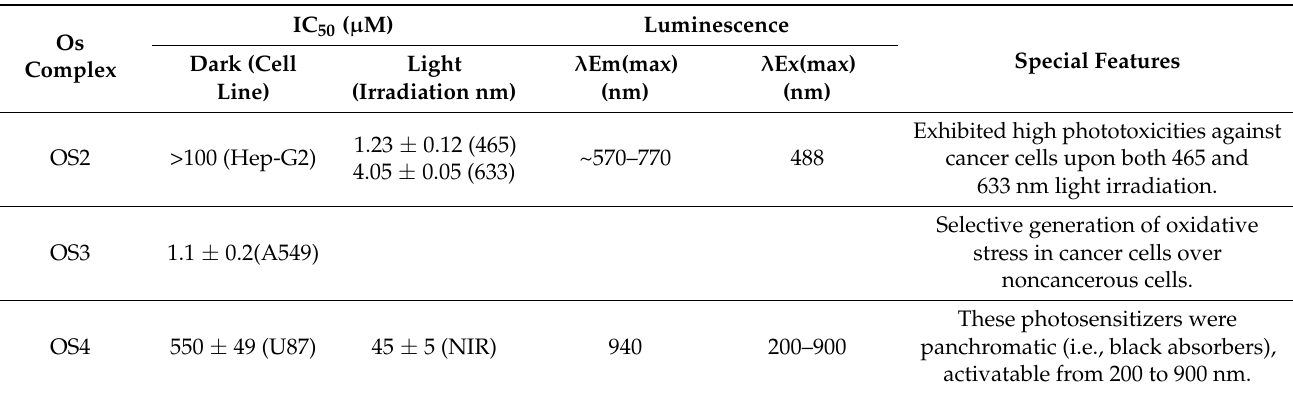
Table 5. A summary of the IC 50 values, luminescent properties, and special features of osmium complexes: tridentate terpyridine complex OS2 [105], half-sandwich osmium(II) complex OS3 [106], and, panchromatic osmium(IV) complex OS4